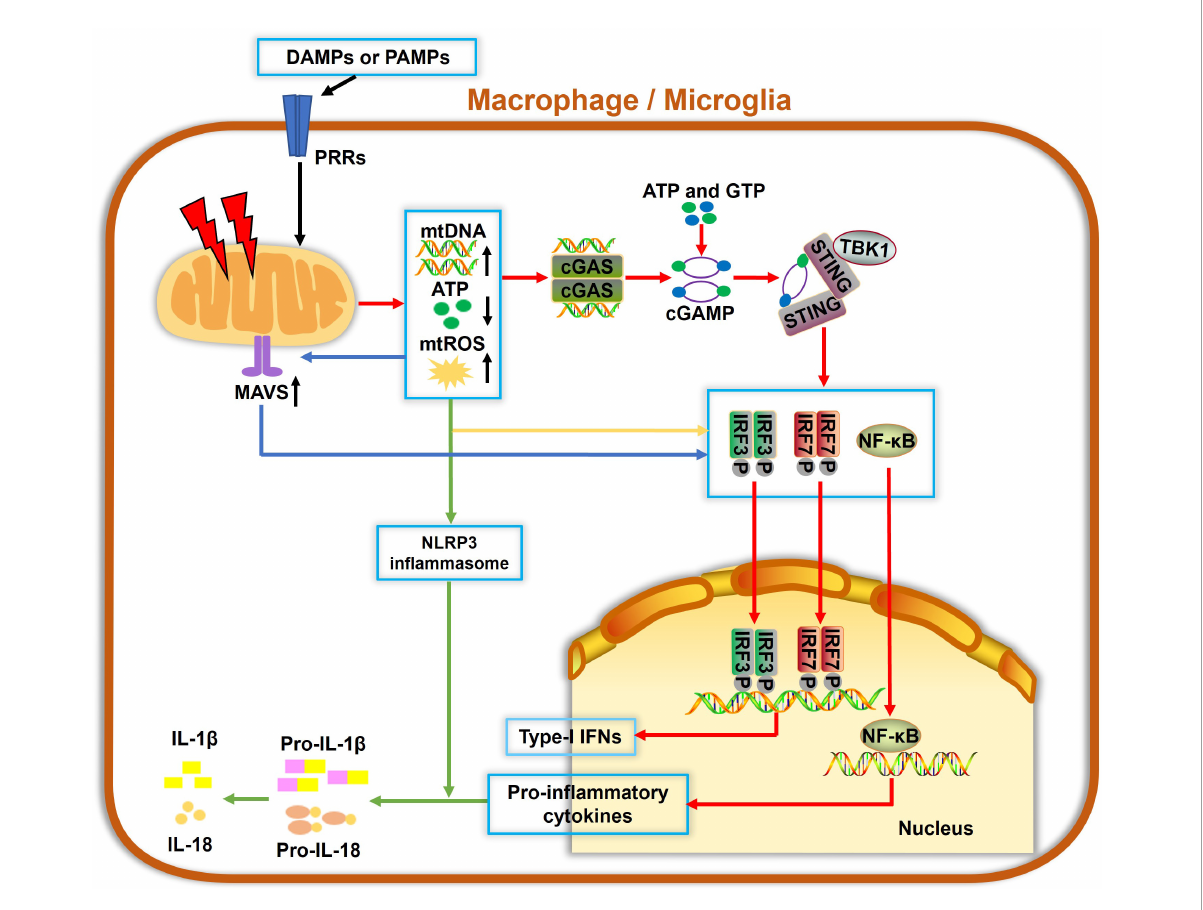
FIGURE2 Mitochondria involvement in innate immune responses in macrophage/microglia. Damage-associated molecular patterns (DAMPs) and pathogen-associated molecular patterns (PAMPs) can be recognized by pattern recognition receptors (PRRs) to cause mitochondrial damage, which leads to increased mitochondrial reactive oxygen species (mtROS) formation, mitochondrial DNA (mtDNA) release, and decreased ATP generation. Cyclic guanosine monophosphate-adenylate synthetase (cGAS) is a cellular DNA sensor that primarily recognizes double-stranded DNA, i.e., mtDNA, using ATP and GTP as substrates to produce the second messenger cGAMP, which then binds to and trigger stimulator of interferon genes (STING) oligomerization. Activated STING recruits TBK1 and activate downstream IRF3, IRF7, or nuclear factor- κ B (NF- κ B), ultimately inducing the expressions of type-I interferons (IFNs) and proinflammatory cytokines. Also, mtDNA and mtROS are canonical activators of the NLRP3 inflammasome and IL-1 β secretion. Additionally, mitochondrial antiviral signaling (MAVS) protein is a RIG-like receptor (RLR) localized on the OMM. mtROS accumulation potentiates the MAVS downstream cascade, which also contributes to activations of NF- κ B, IRF3, and IRF7, leading to a pronounced generation of cytokines and IFNs. Collectively, damaged mitochondria serve as hubs of